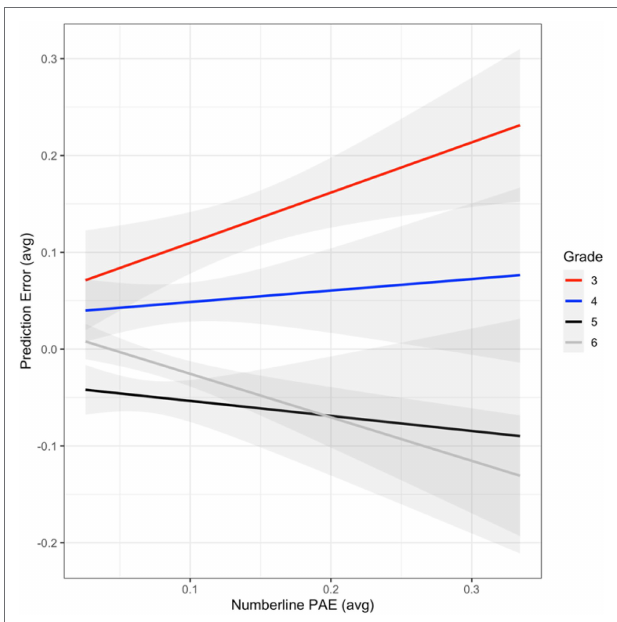
FIGURE 2 | Smoothed (using stat_smooth = glm) PE (prediction error) measure (non-transformed) predicted by number line PAE and